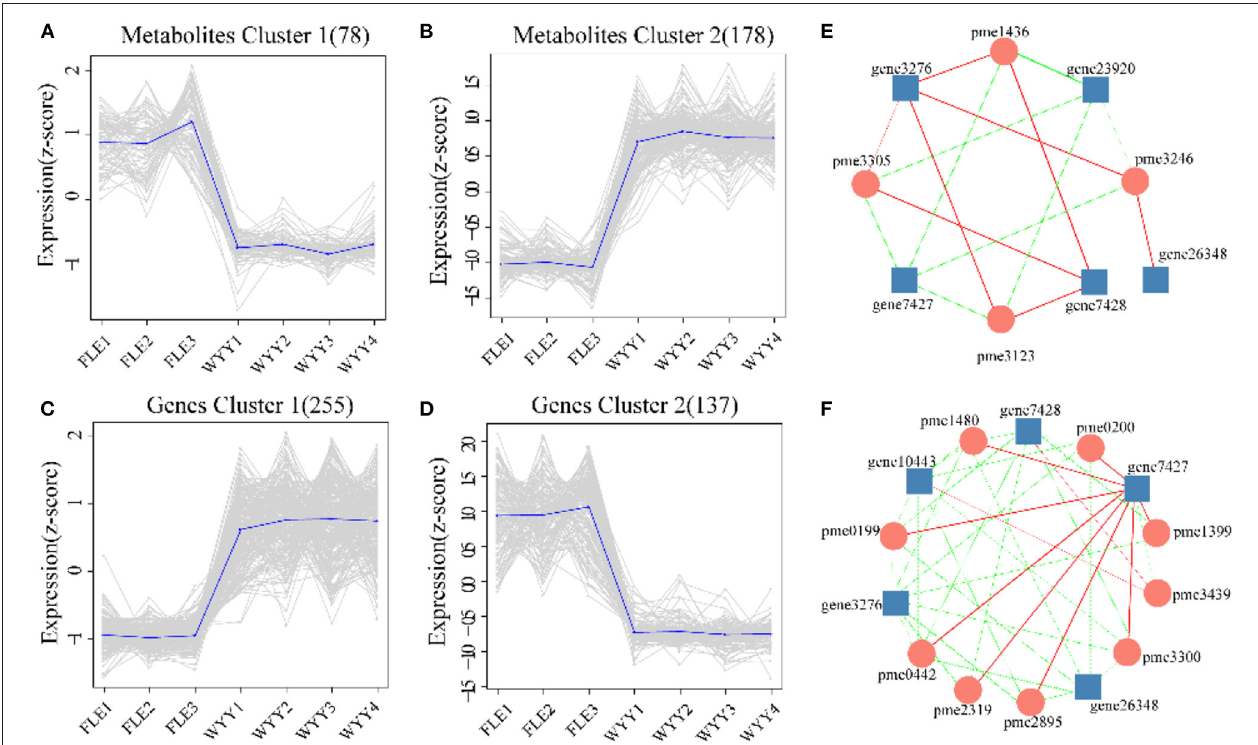
FIGURE 7 | Trend analysis and the co-expression analysis of DEGs and DEMs. (A,B) K-means clustering analysis of the DEMs into two clusters according to their expression profile. (C,D) K-means clustering analysis of the DEGs into two clusters according to their expression profile. (E) Interaction network of DEGs and DEMs involved in phenylpropanoid biosynthesis. (F) Interaction network of DEGs and DEMs associated with flavonoids biosynthesis. Metabolites are shown in circles and gene IDs are shown in squares. Edges colored in “red” and “green” represent positive and negative correlations,